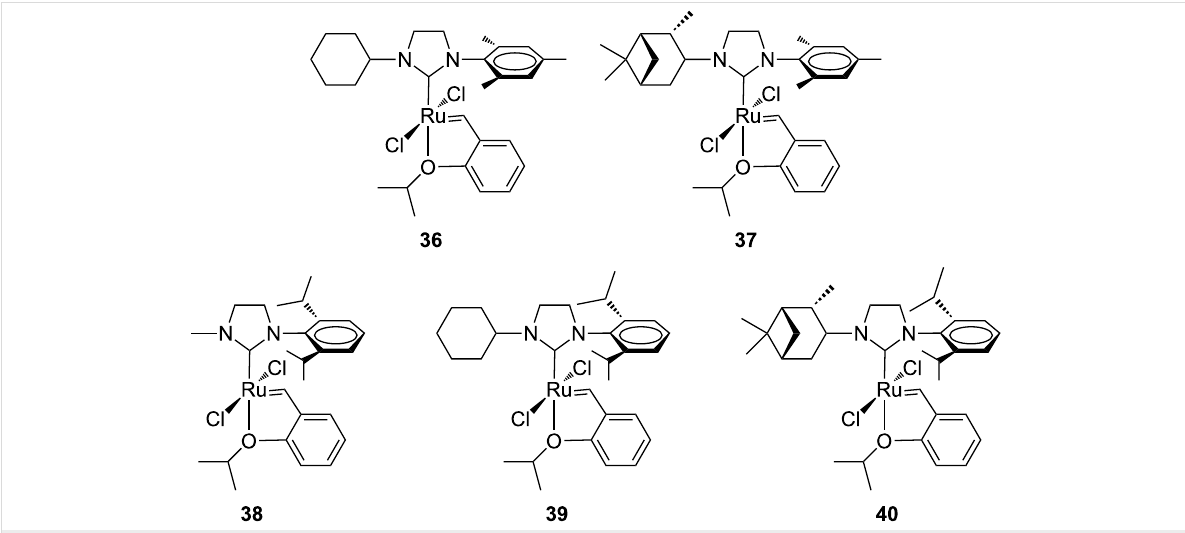
Figure 10: Hoveyda-type complexes with an N -alkyl, N’ -mesityl ( 36 , 37 ) and an N- alkyl, N’ -2,6-diisopropylphenyl ( 38 – 40 ) NHC ligand.